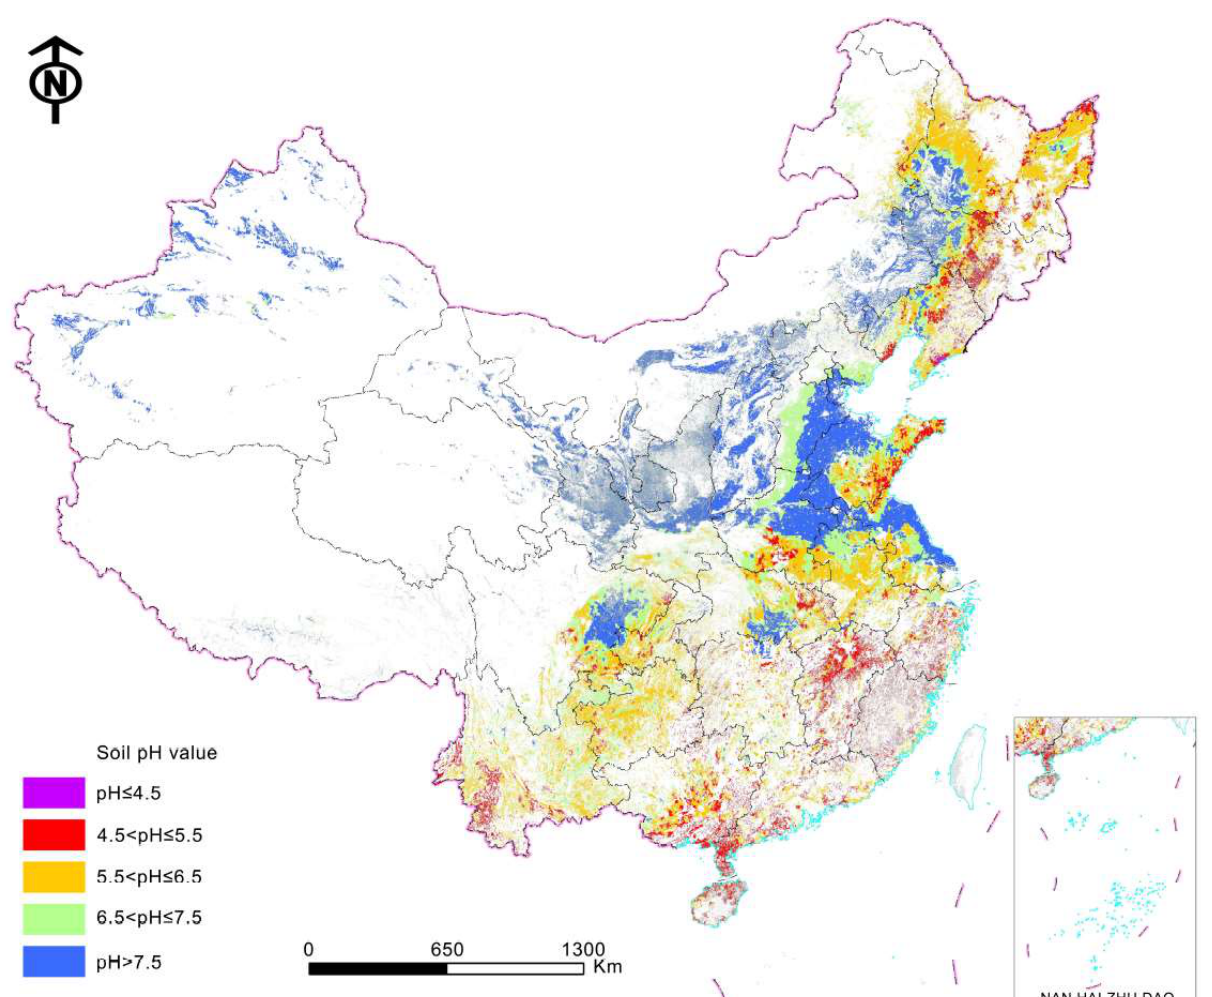
Figure 4. Soil pH in the 0–20 cm layer of cultivated land in the 2010s in China. Table 2. Changes in paddy soil pH in the 0–20 cm layer from 1980 to 2010 in China. Region